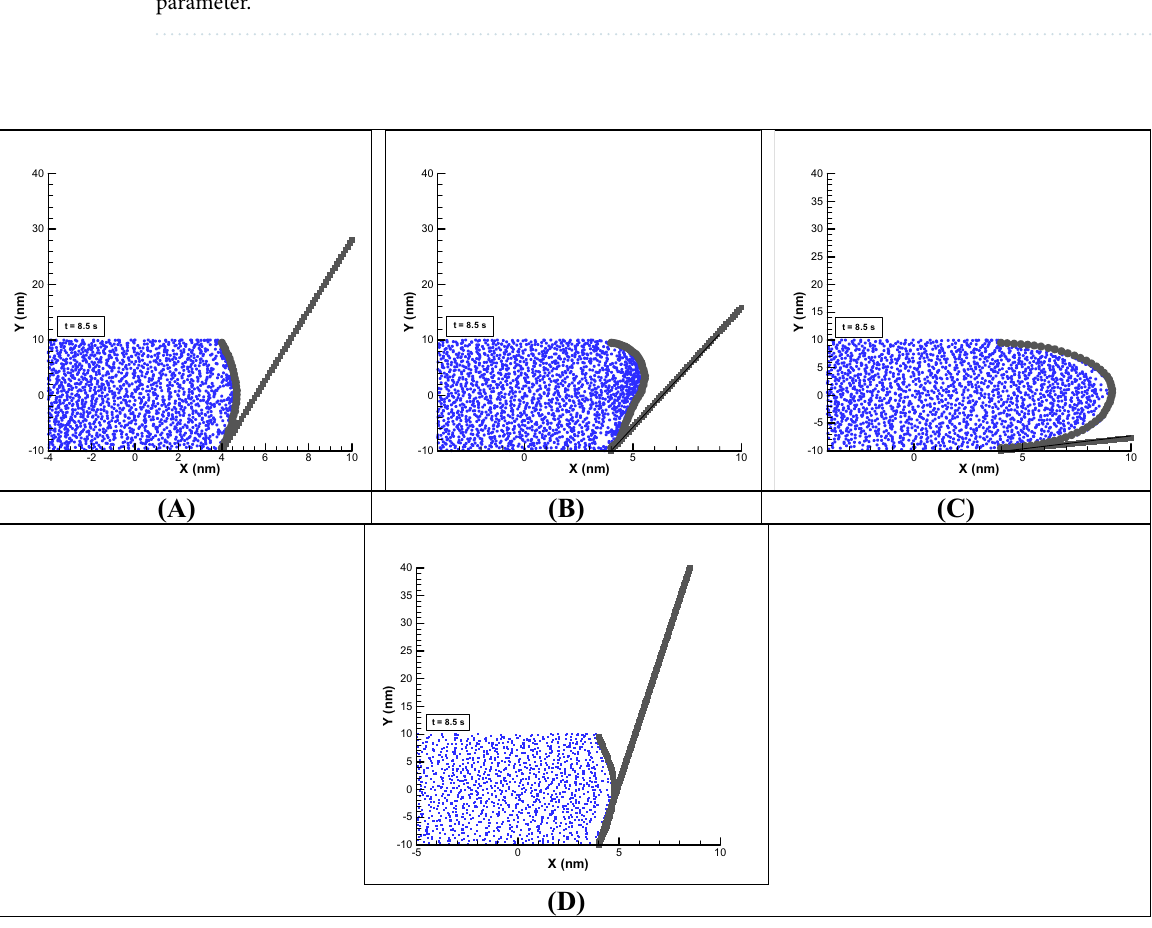
Table 2. Ratio of average velocity and strain of polymer chain for different kH, zeta potential and electric field parameter.